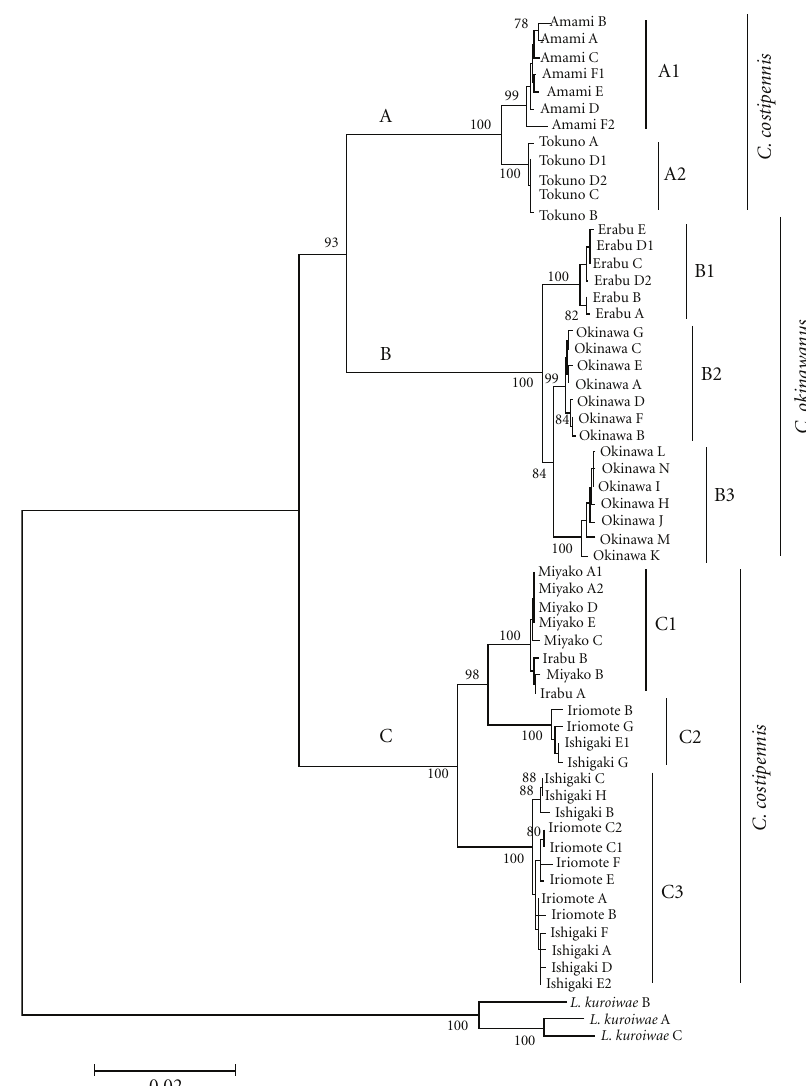
Figure 2: Neighbor-joining tree based on the Jukes-Cantor distances calculated using the 2,206 bp long combined data set including both mitochondrial CO and rDNA sequences. Sequences of di ff erent individuals collected from the same locality are indicated by a numeral in the taxon name. Bootstrap confidence levels calculated based on 1000 replications are shown near the